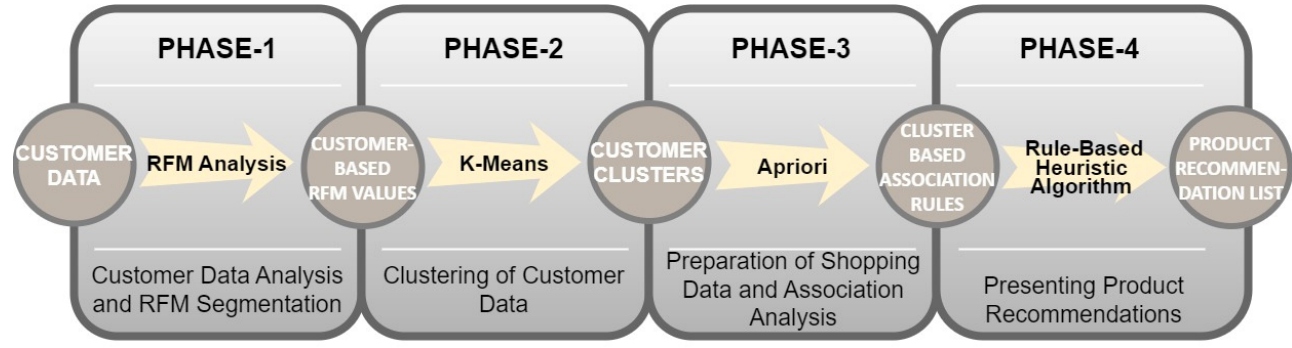
Figure 4. Conceptual design of the proposed system.